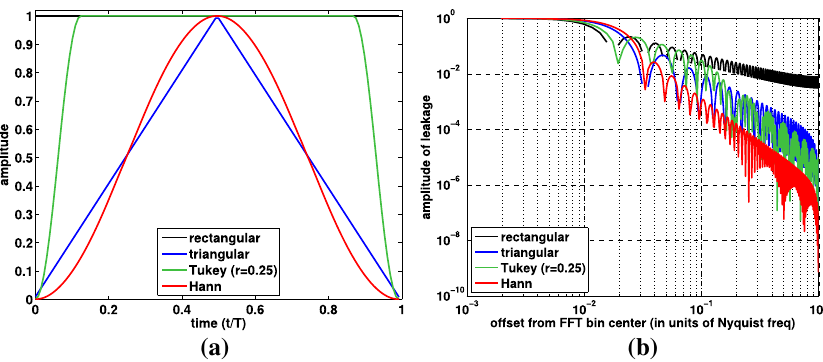
Fig. 88 Panel a Plots of window functions defined in the main text. Panel b Amplitude of spectral leakage for different windows as a function of the offset from the bin center in units of the Nyquist frequency f N ≡ 1 /( 2 Δ t ) . The dips arise because we are using a finite number of samples ( N = 128) to represent the